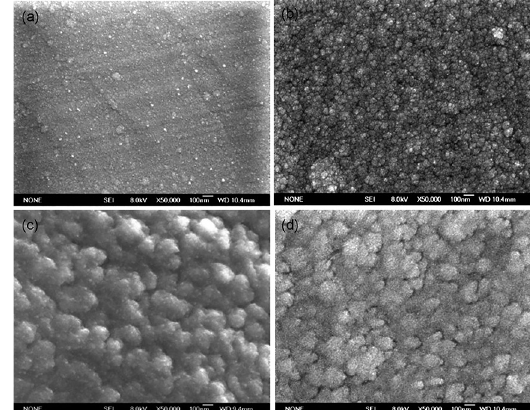
Figure 6: FESEM morphology of the coatings at different times under 150W plasma power. (a) 10 minutes, (b) 20 minutes, (c) 40 minutes, (d) 60 minutes.